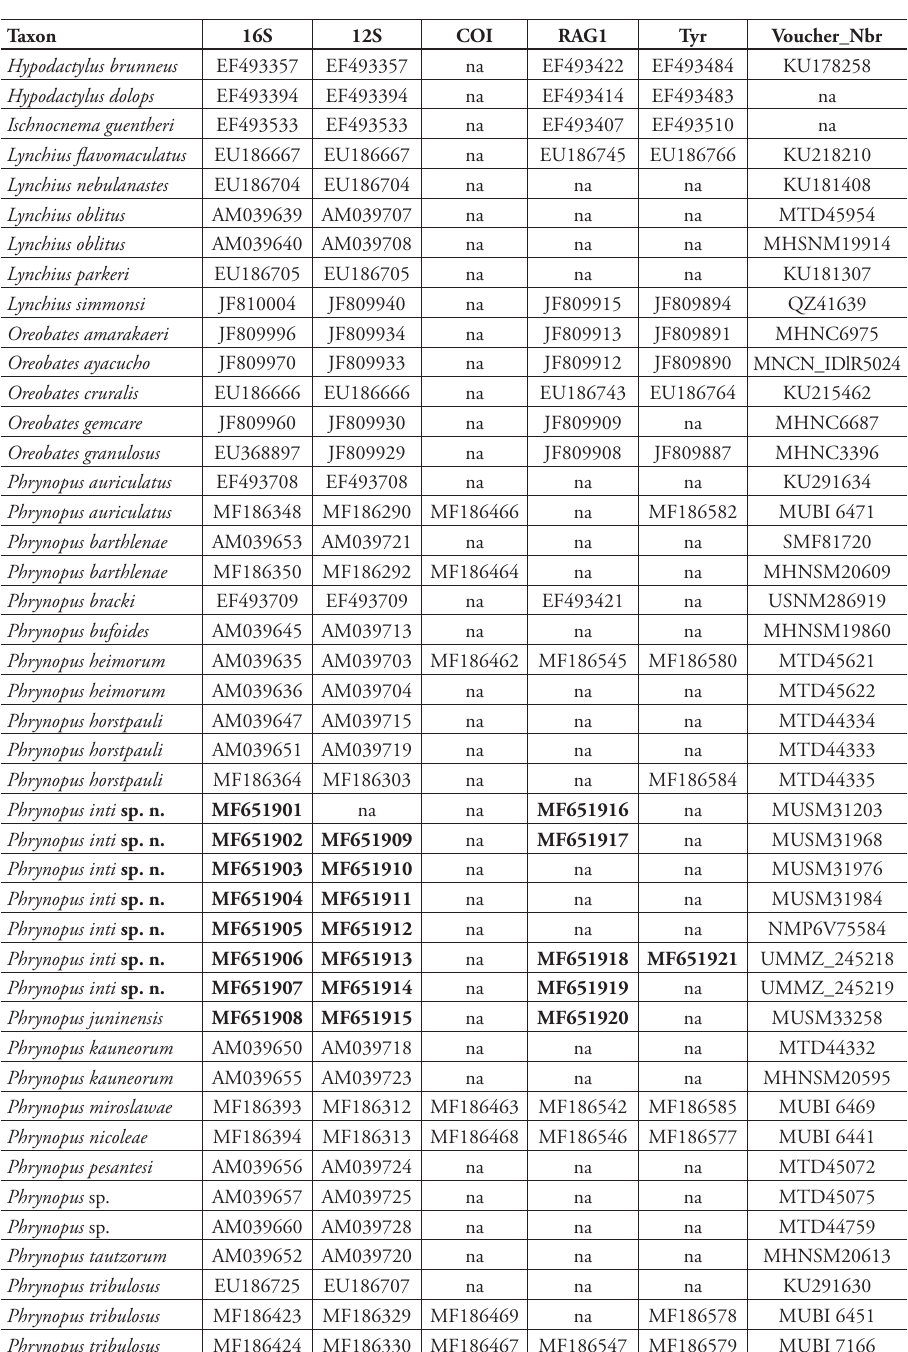
Table 1. GenBank accession numbers for the taxa and genes sampled in this study. Bold font indicates new sequences generated for this study. Taxonomy follows Padial et al.